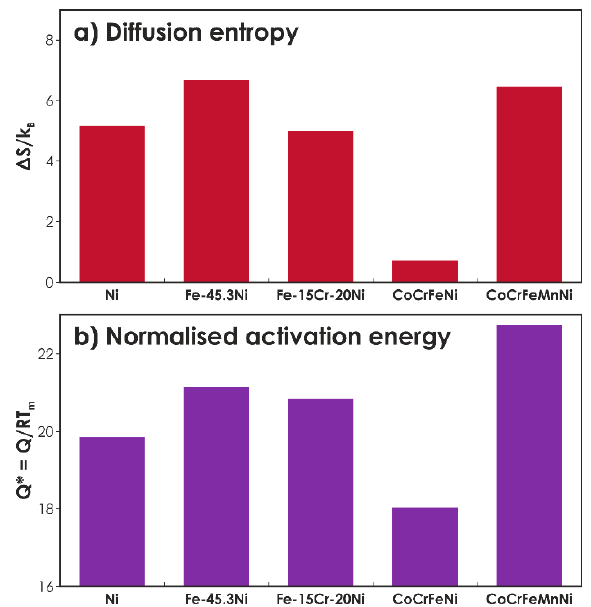
Figure 5. ( a ) Di ff usion entropy and ( b ) normalized activation enthalpies for the FCC systems (after [31]).